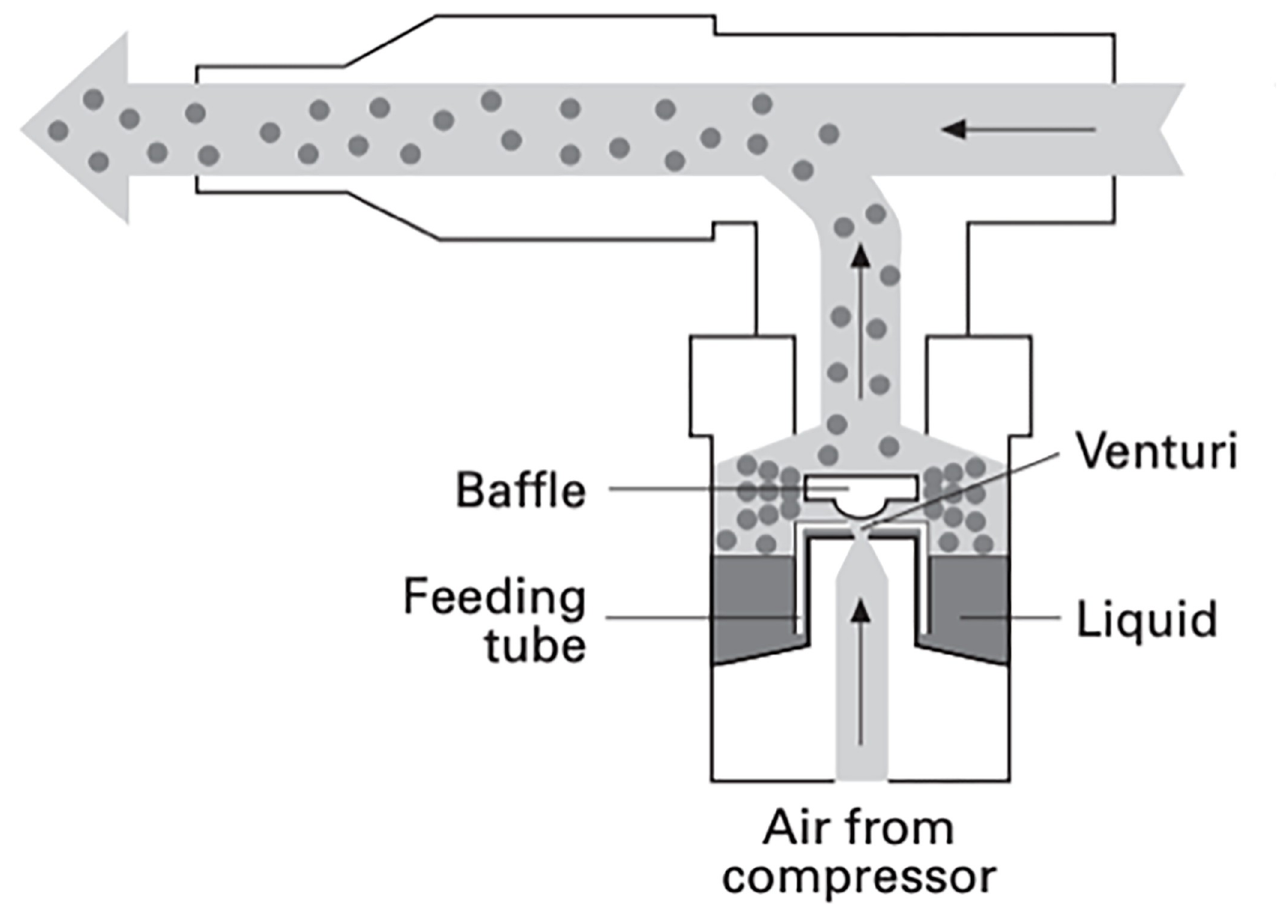
Fig 1. Nebulizer Venturi tube design